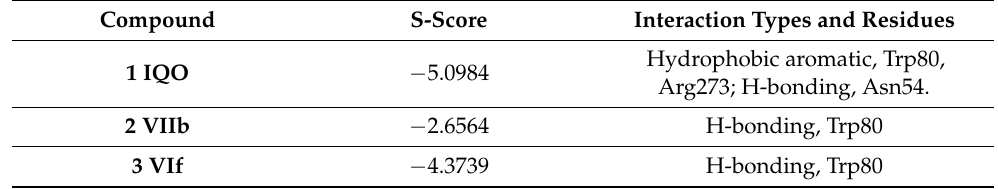
Table 8. The docking scores and the main interactions observed of the most active compounds against Akt active site.